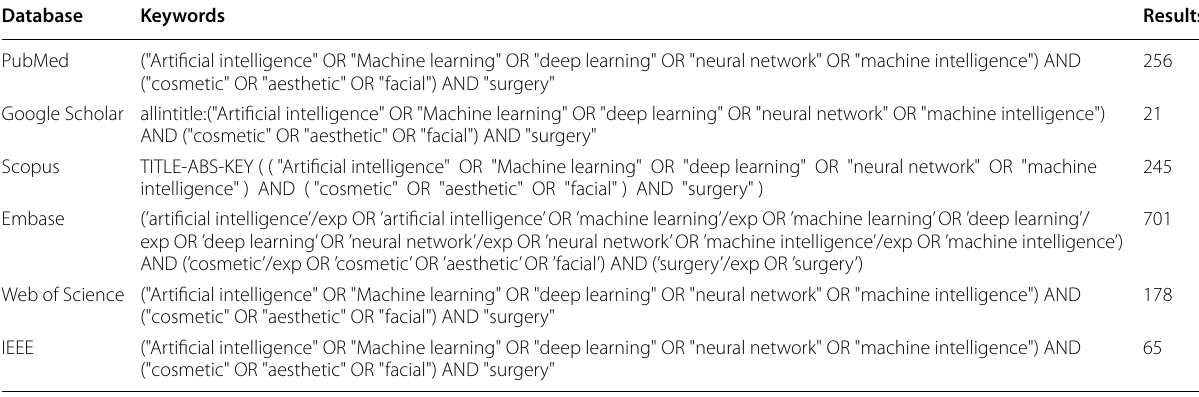
Table 1 The specific search query for each database (till 30th December